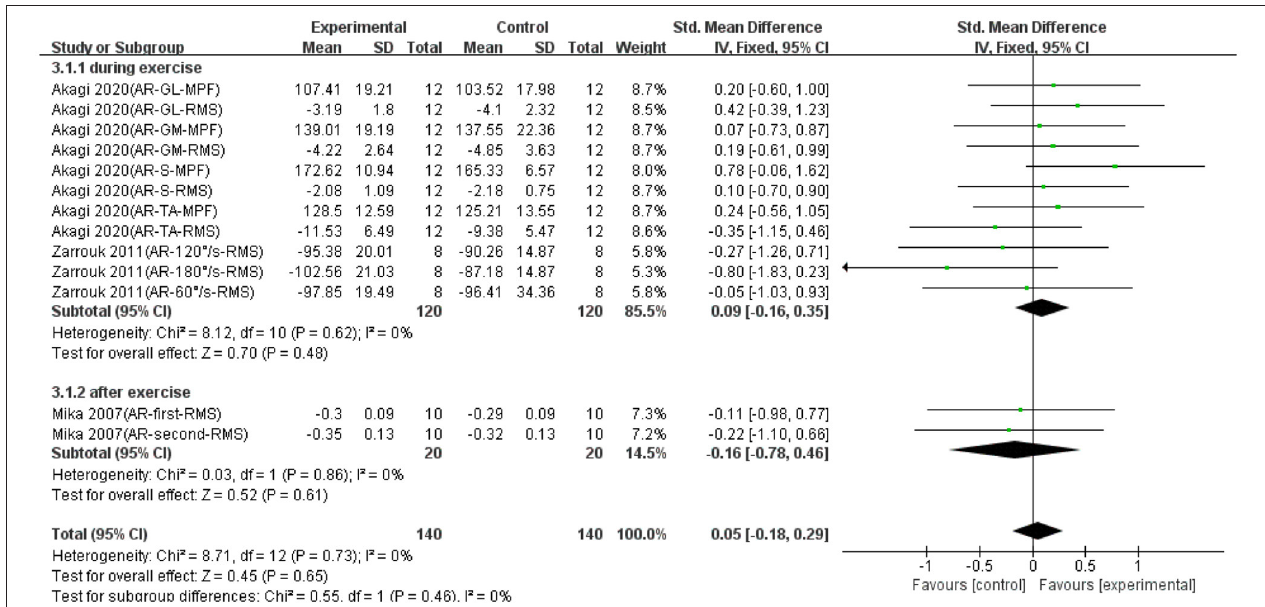
FIGURE 2 | The effectiveness of active recovery (AR) conducted at different time points on electromyography (EMG) signals of exercise-induced muscle fatigue.